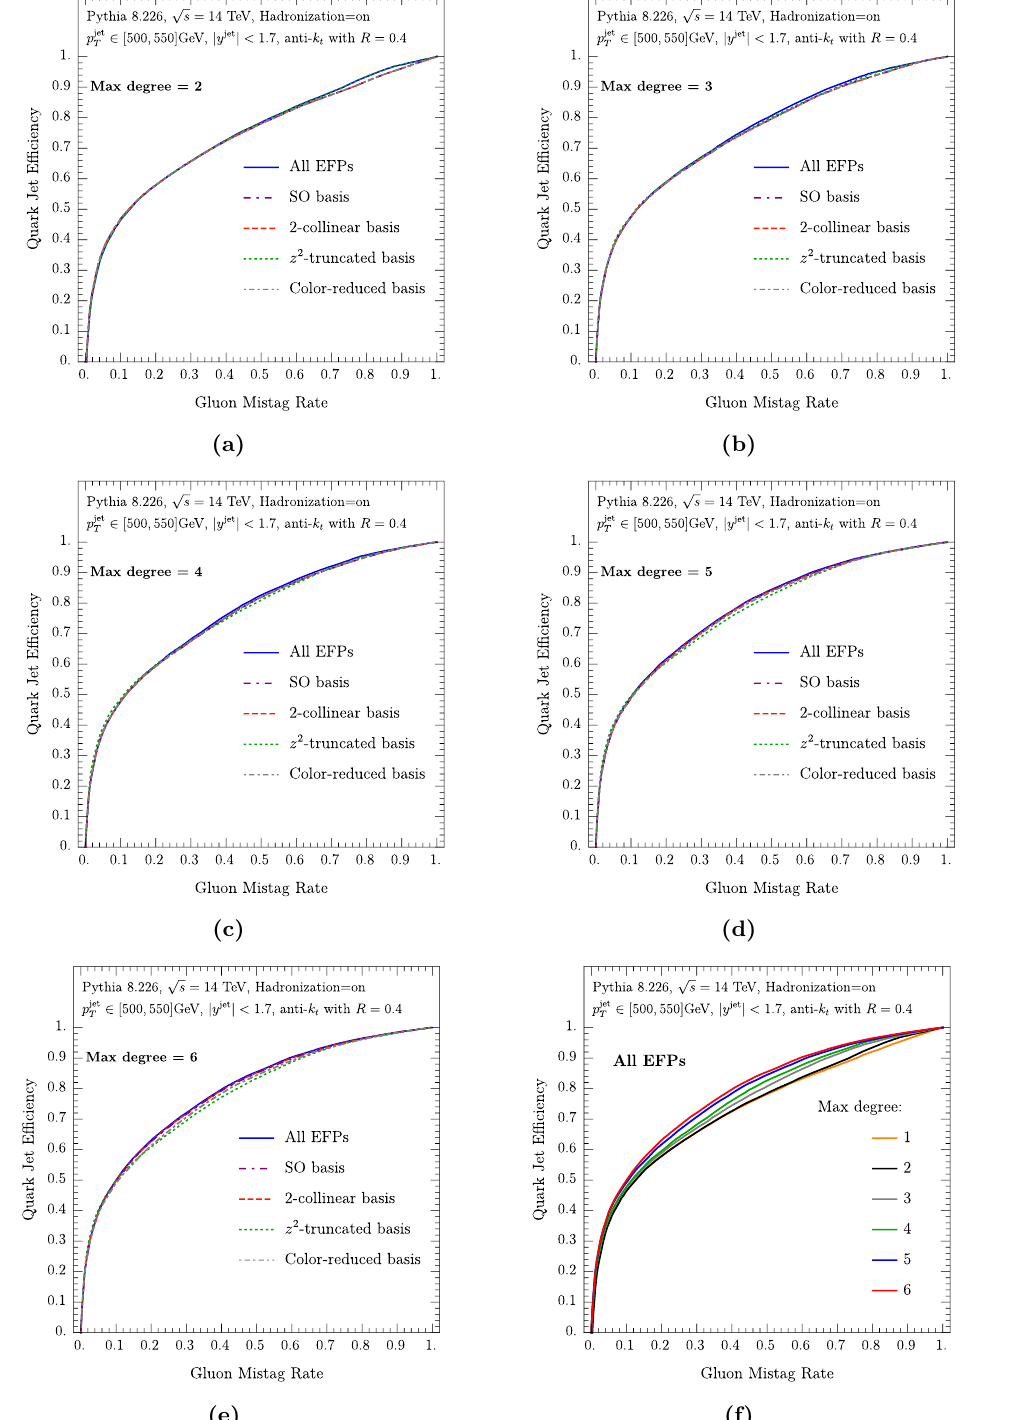
Figure 11. ROC curves for quark/gluon discrimination, organized by maximum degree for the dif- ferent inputs used for classification: all EFPs, strongly-ordered basis, 2-collinear basis, z 2 -truncated basis, and color-reduced (1-collinear) basis. To help interpret the comparison, in figure 11f we show the ROC curves for all EFPs by maximum